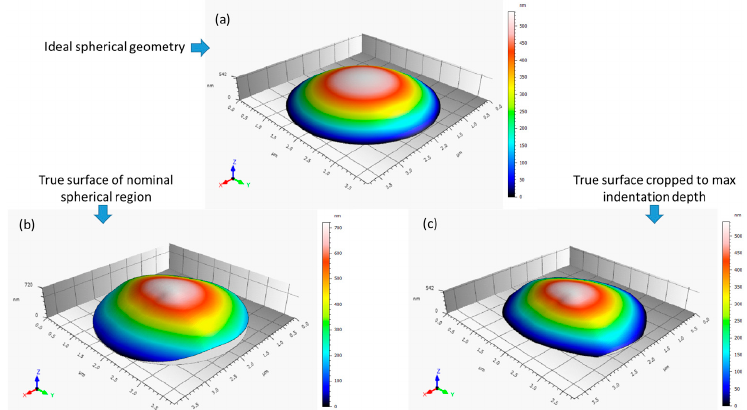
Figure 33. Even though the maximum indentation depth associated with a nanoindenter tip of 2.71 µ m is 794 nm according to h = 2710 1 − 2 − 0.5 , the max cut o ff depth before the transition from spherical shape to a conical geometry was set at 542 nm to readily showcase the spherical geometric profiles. Therefore, at 542 nm away from the apex of the perfectly spherical tip, the ideal spherical geometry is presented in ( a ). ( b ) Unveils the true surface profile associated with the tip from Micro Star Technologies up to 794 nm from the apex. For comparison with ( a ), ( c ) captures the actual surface cropped to the same vertical dimension as the ideal surface, highlighting the deviation. Renderings were normalized in the x, y, and z directions.